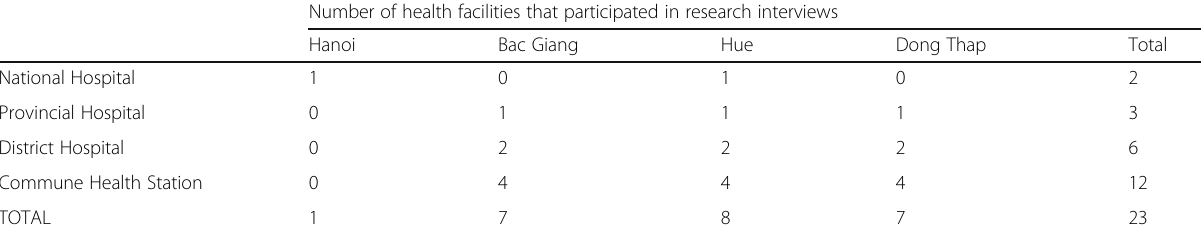
Table 3 Sampling Plan: Number of health facilities where staff were interviewed Number of health facilities that participated in research